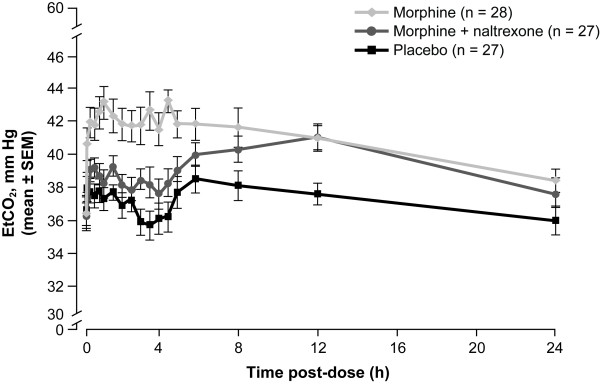
Mean EtCO2 (mm Hg) ± SEM over 24 hours post-dose (PD population).